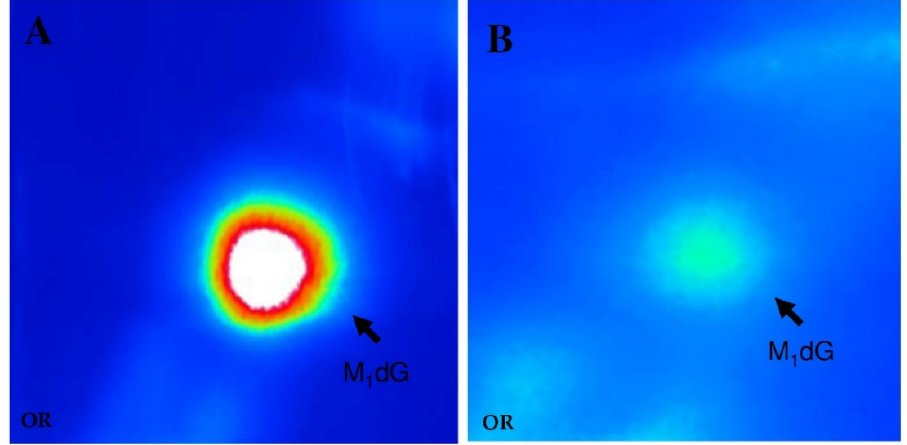
Figure 2. Characteristic chromatographic pattern of 3-(2-deoxy- β - d -erythro-pentafuranosyl)pyrimido [1,2- α ]purin-10(3H)-one deoxyguanosine (M 1 dG) detected in the calf-thymus DNA exposed to 10 mM MDA ( A ) and in the hepatocytes of hepatitis C virus hepatocellular carcinoma patients ( B ). Table 1. Levels of 7-hydro-8-oxo-2′-deoxyguanosine (8-oxodG) and 5-hydroxycytosine (5-OHC) at the codon 176 along the exon 5 sequence of the p53 gene among hepatitis C virus (HCV)-associated hepatocellular carcinoma (HCC) patients and controls, as well as hepatocytes in vitro treated with 0.2 mM xanthine plus 5.0 mU xanthine oxidase (XO)-treated. Frequency of 3-(2-deoxy-β- D -erythro- pentafuranosyl)pyrimido[1,2-α]purin-10(3H)-one deoxyguanosine (M 1 dG) are reported. Oxidative Base Lesions at the Codon 176 of the p53 Gene and Generation of M 1 dG in Genomic DNA 0.34 ± 0.03 of